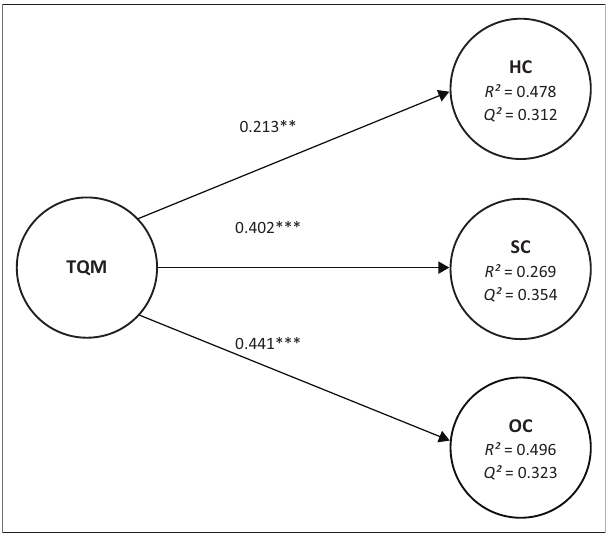
FIGURE 2: Structural model results.